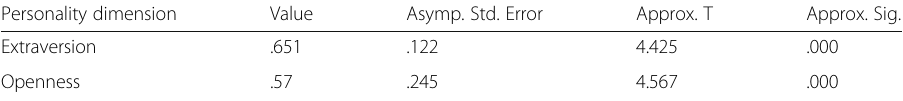
Table 4 Kappa agreement degree results Personality